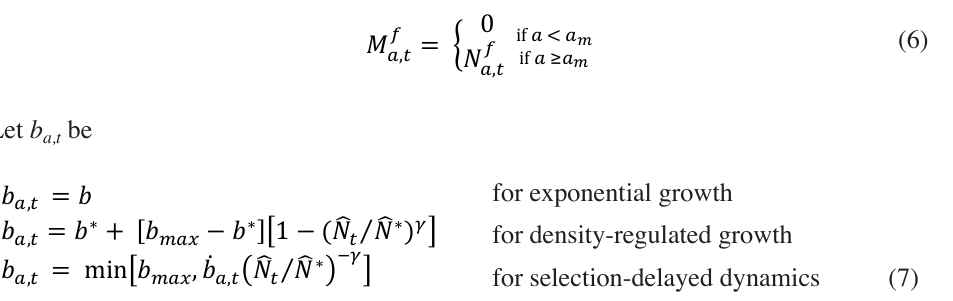
for exponential growth for selection-delayed dynamics